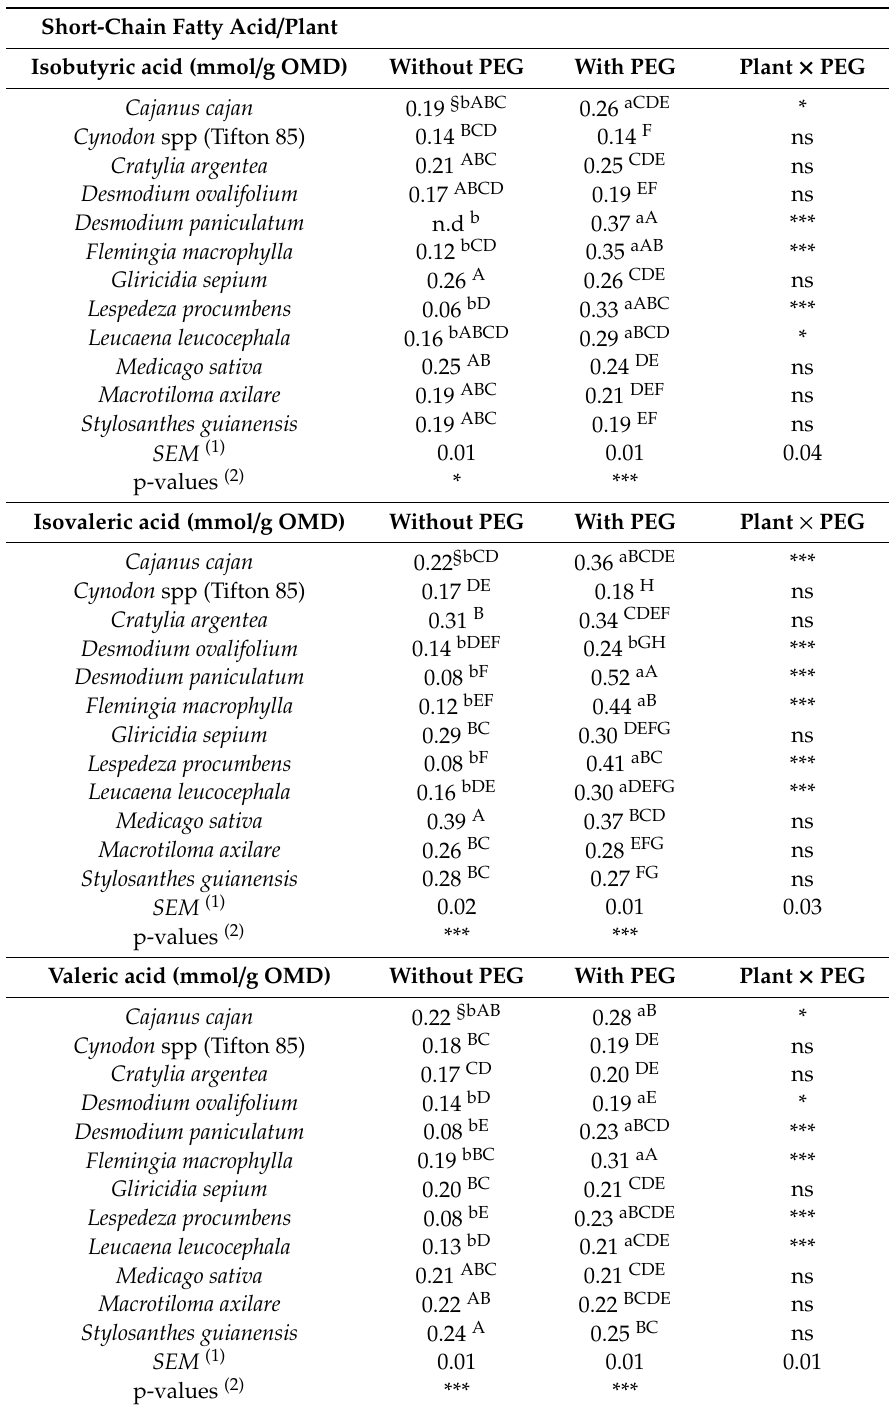
Short-Chain Fatty Acid /